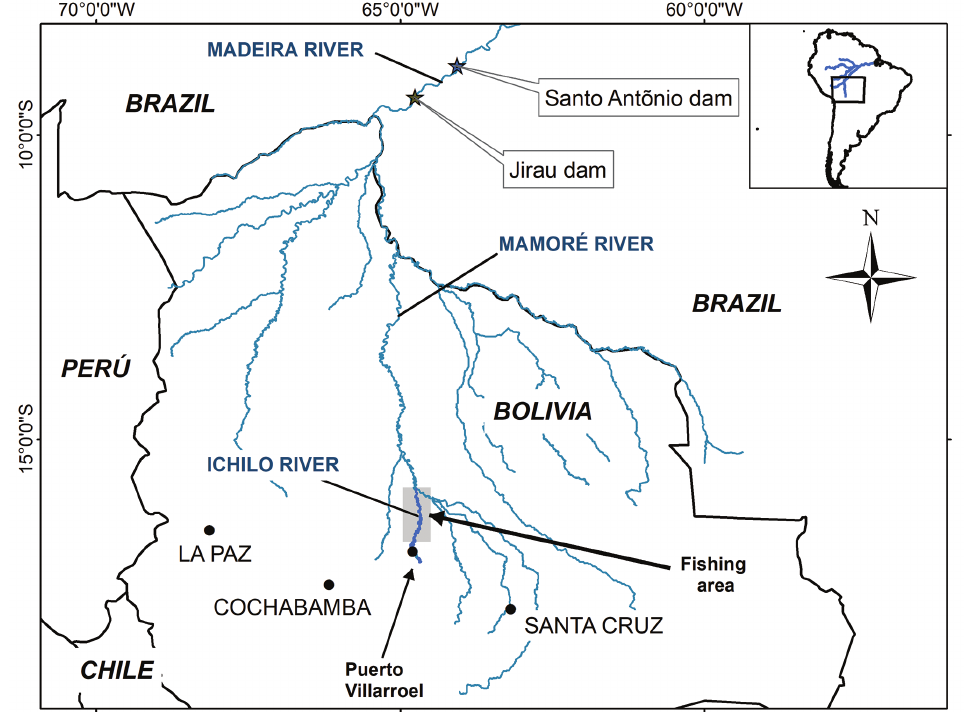
Fig. 1. Upper Madeira River basin, showing landing site Puerto Villarroel and fishing area in the Ichilo River (Bolivian Amazon), as well as the Santo Antônio and Jirau dams (Brazilian